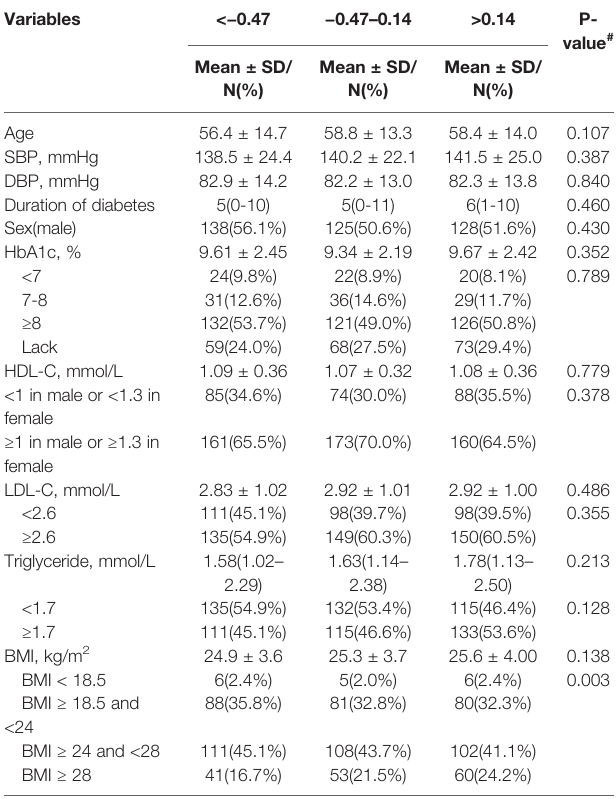
TABLE 7 | Clinical characters according to factor 3 classi fi cation.